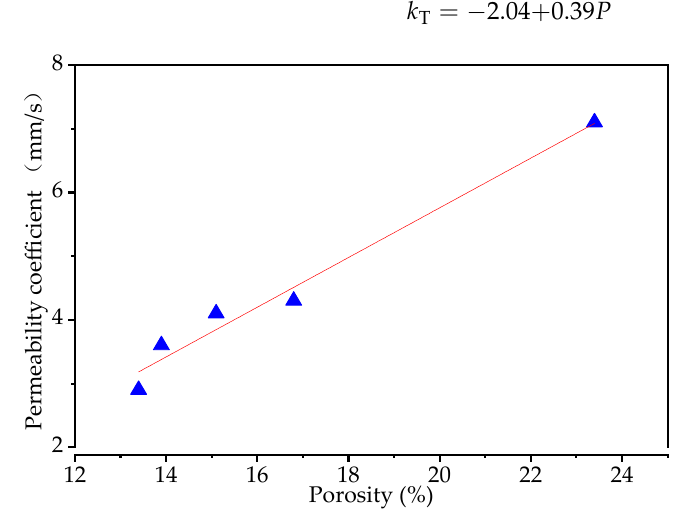
Figure 12. The relationship between permeability and